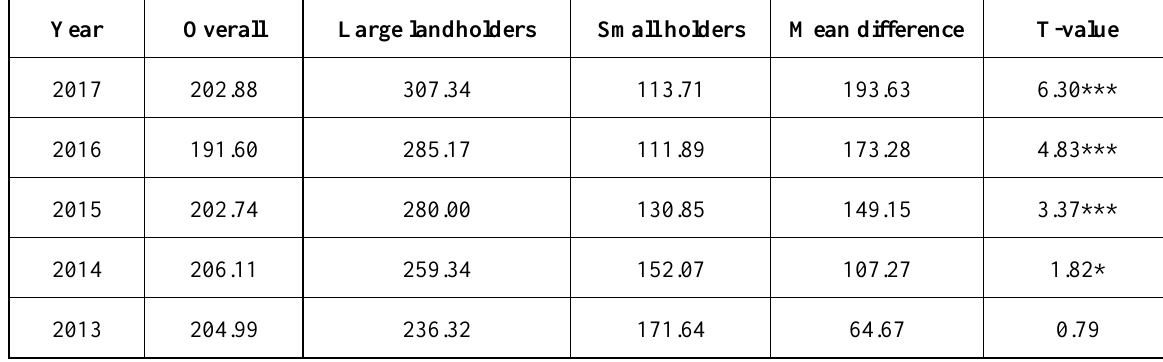
Table 3. Production trend of large cardamom in the study area